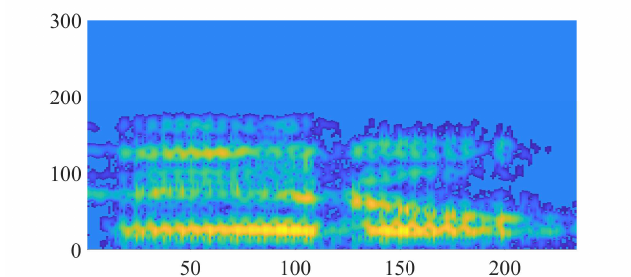
Figure 4. Normalized spectrogram corresponding to the Spanish audio “cero” (0) before